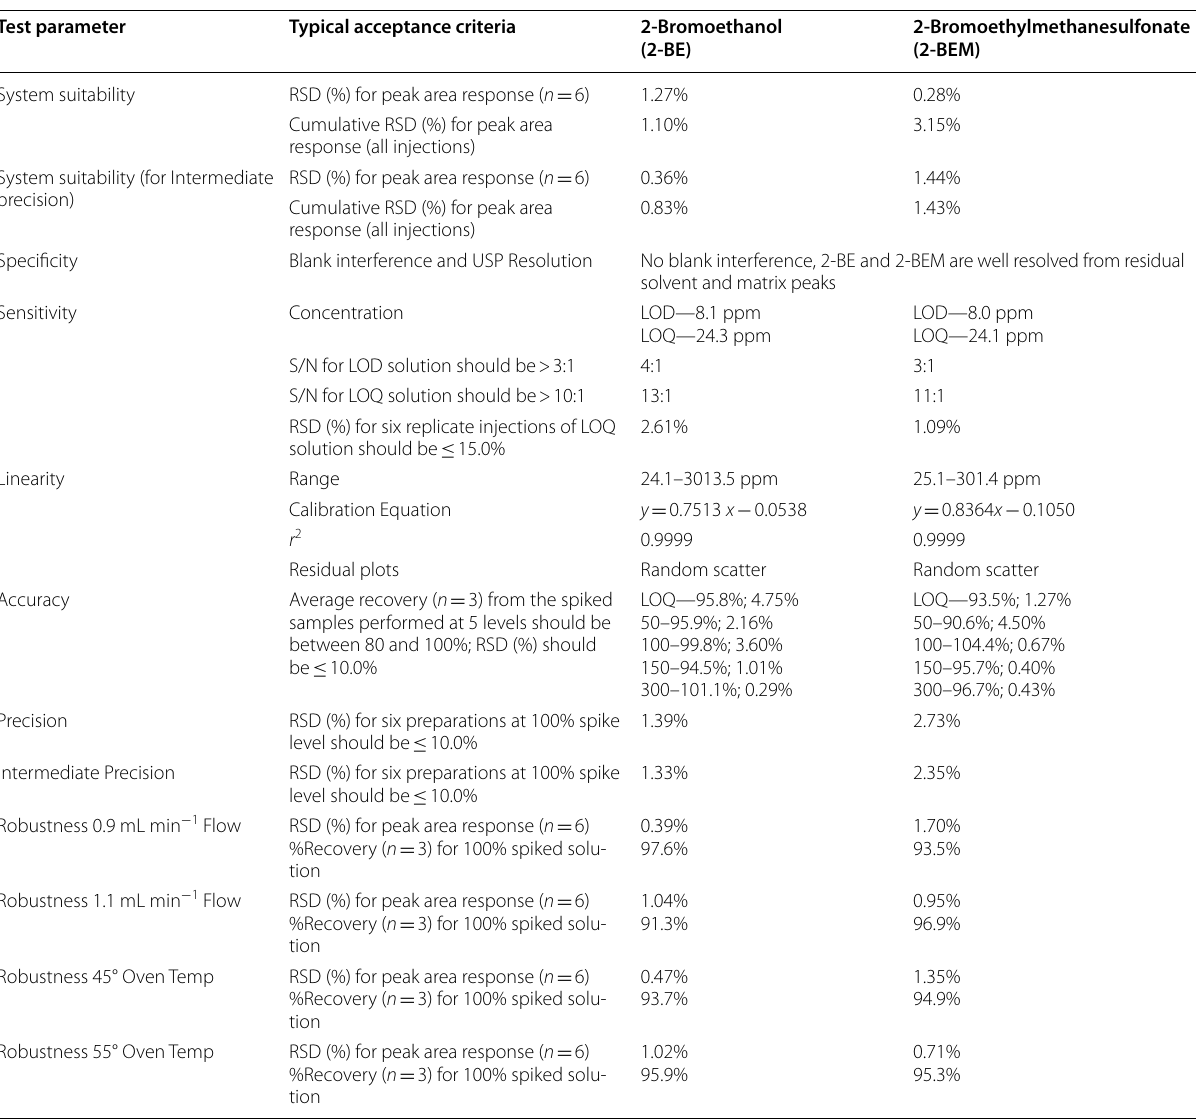
Table 2 Method validation data